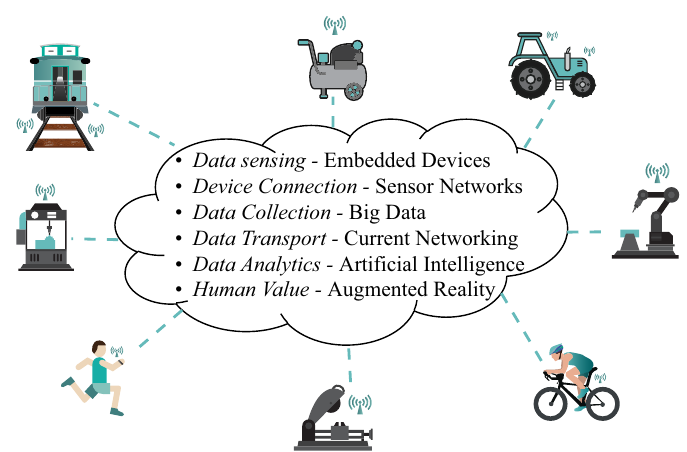
Figure 1. The Internet of Things